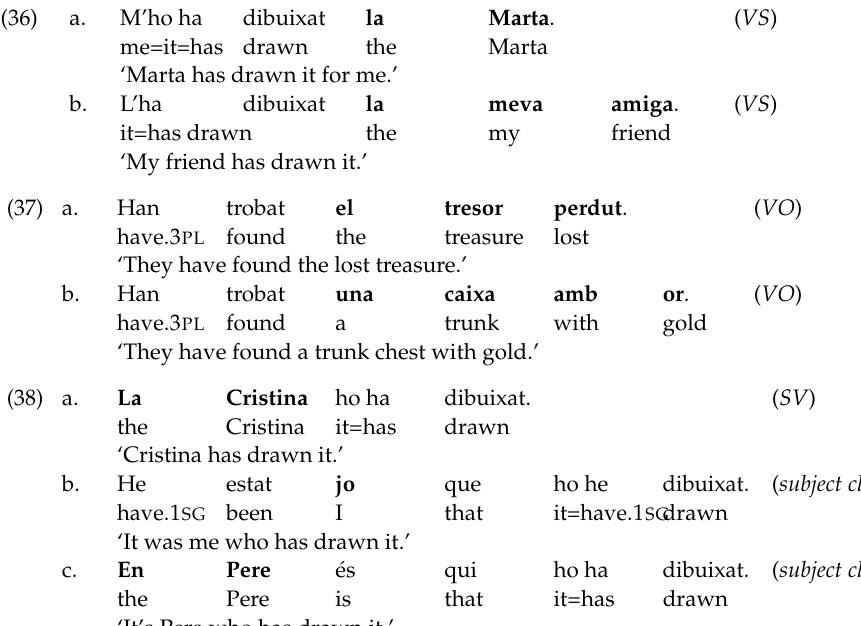
Figure 1. The production experiment: The realization of information focus by category and position. Participants overwhelmingly produced postverbal foci both for subjects (90.9%) and object (94.8%), as exemplified in (36) and (37), respectively, along with a marginal number of preverbal (subject = 5.1%; object = 2.6%) and clefted foci (subject = 4.0%; object = 2.6%), as in